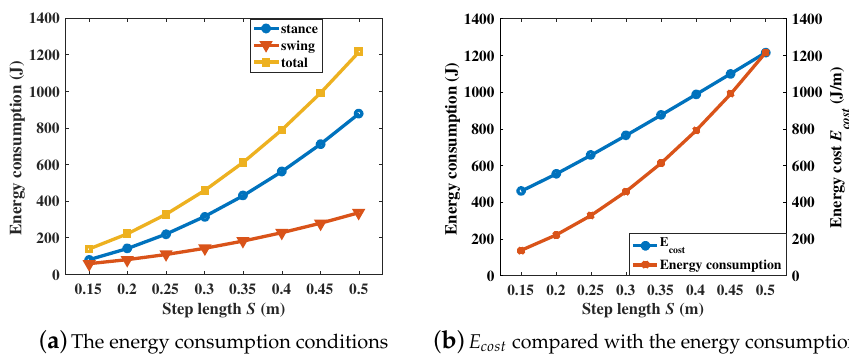
Figure 13. The energy consumptions with different step lengths.